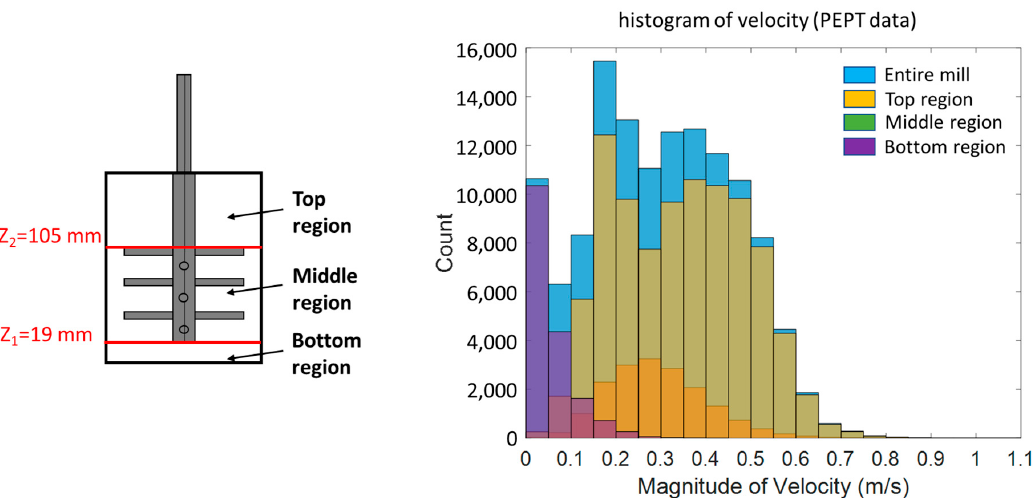
Figure 13. Histogram of the velocity magnitude for the attritor mill and for three sub-domains of the mill: top region, middle region and bottom region. PEPT test case using the bead loading of 2.4 kg, the impeller clearance of 19 mm and the impeller speed of 300 rpm.